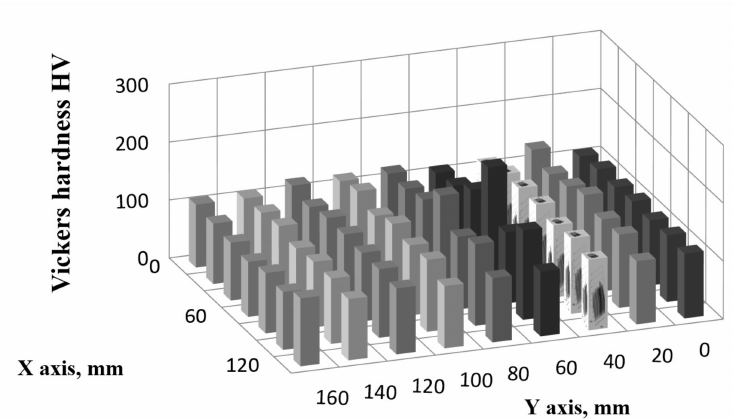
Figure 5. The differences in Vicker’s hardness on the sample’s surface.